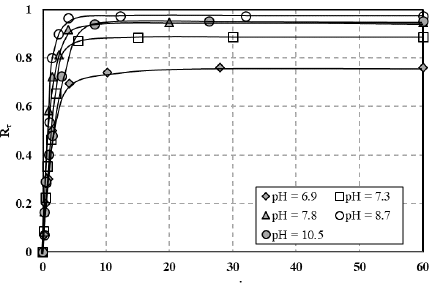
Figure A12. Changes in Zn(II) temporary removal ratio during ion and precipitate flotation from solution containing Al(III), Cu(II), and Zn(II) mixture—effect of pH (c 0 = 2 mmol dm − 3 , c SDS = 0.187, u G = 1.51 mm s − 1 ).